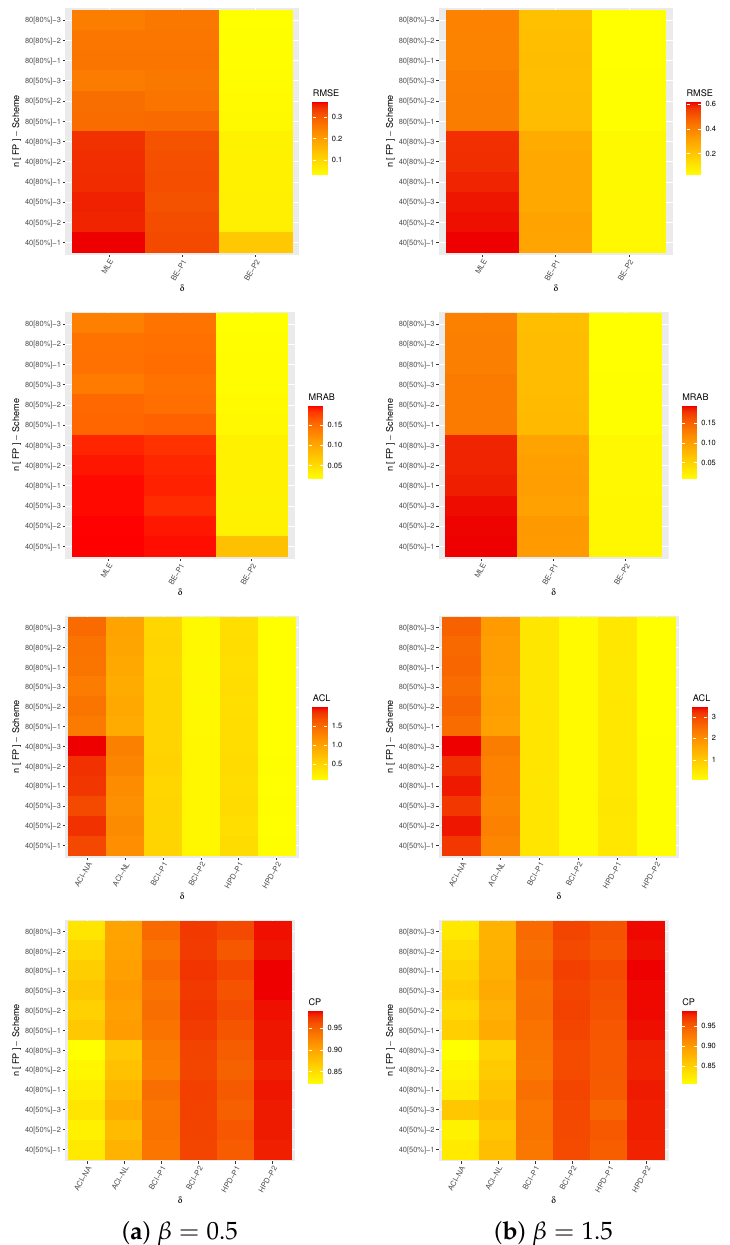
Figure 4. Heat-map for the Monte Carlo results of δ